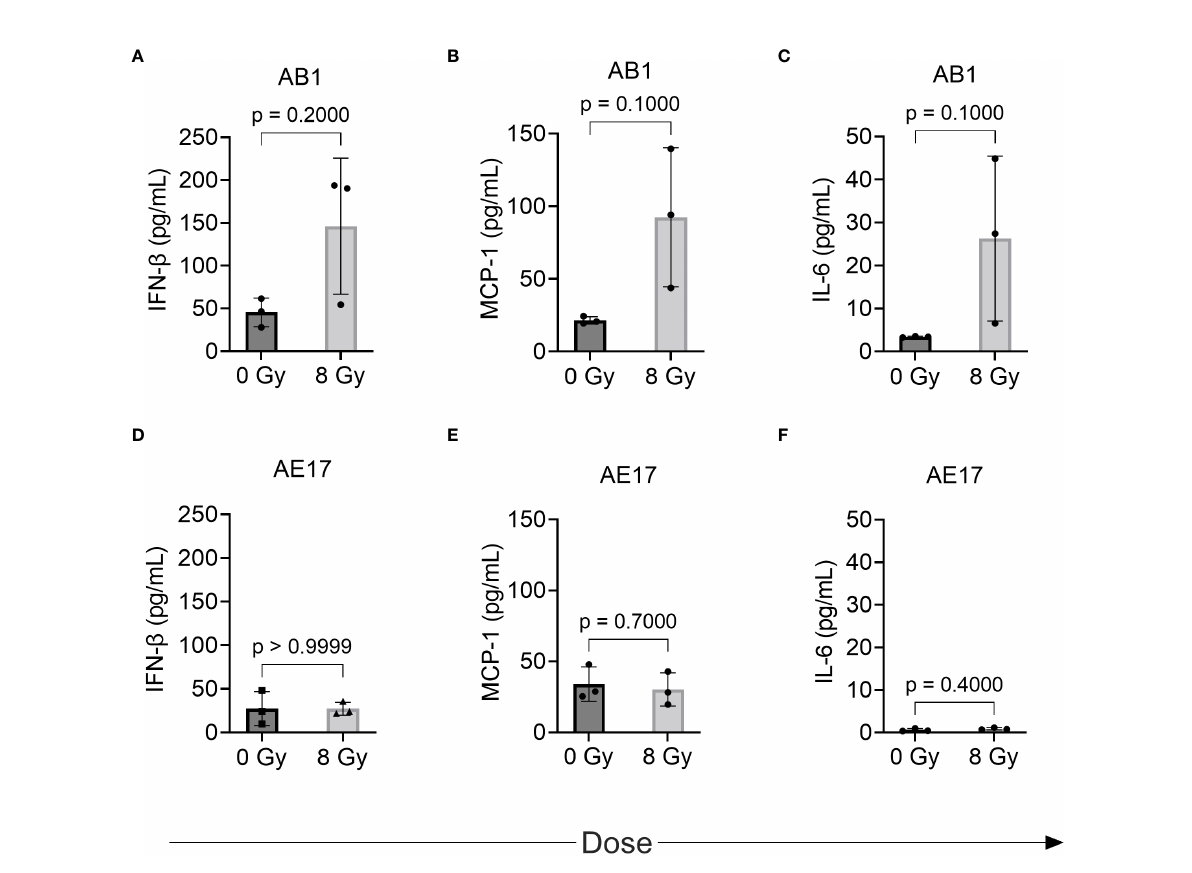
FIGURE 4 The effect of radiation on cytokine production by murine mesothelioma cell lines as measured by multiplex assay. (A – F) Concentrations of IFN- b , MCP-1 and IL-6 respectively in AB1 (A – C) and AE17 (D – F) cell lines, 72 h after irradiation with 8 Gy compared to sham-irradiated (0 Gy) controls. Data are presented as mean ± S.D. of n = 3 independent experimental repeats. P-values were determined by the non-parametric Mann-Whitney U